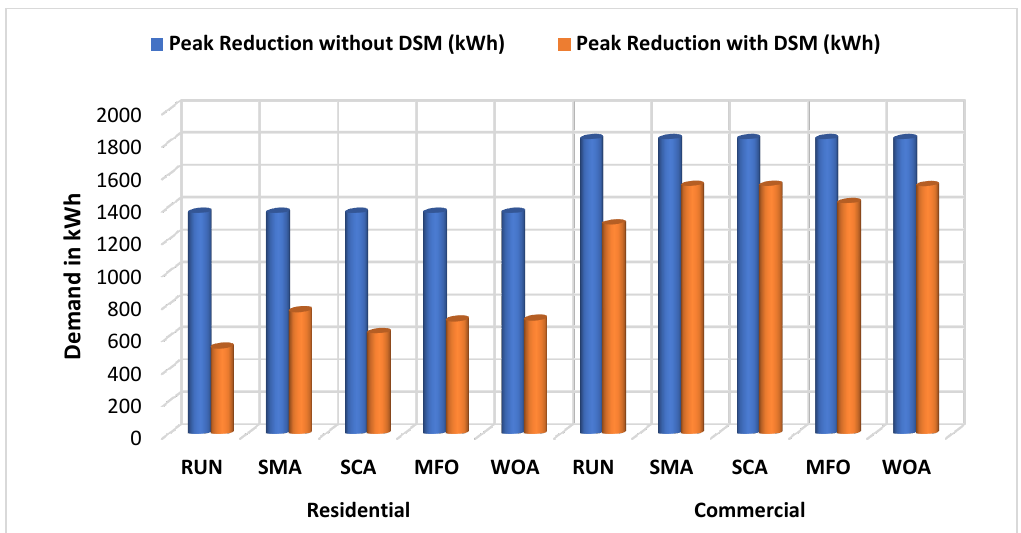
Figure 10. Peak demand reduction by strategic conservation.